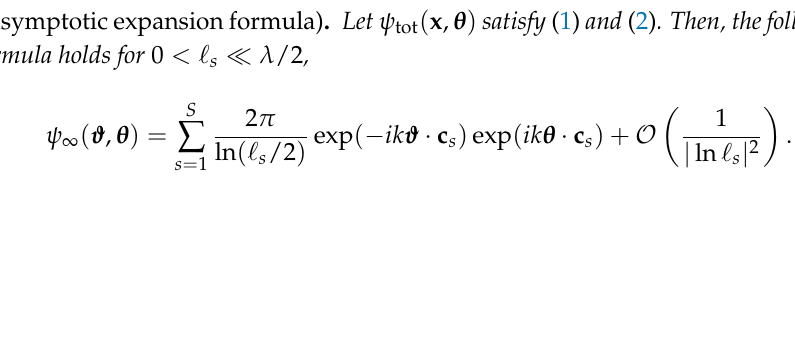
Figure 1. Illustration of the set of incident directions S 1 conducting crack Γ m